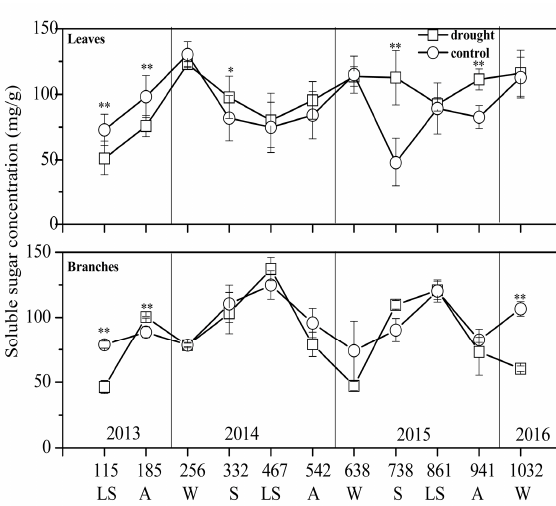
Figure 5. Soluble sugar concentrations in the leaves and branches of Pinus massoniana under control and drought treatments (mean ± SD). Samples were collected in late summer (LS), autumn (A), winter (W), and spring (S) from 2013 to 2016. Variables marked with asterisks indicate a significant difference between the control and drought groups (** p < 0.01, * p < 0.05).